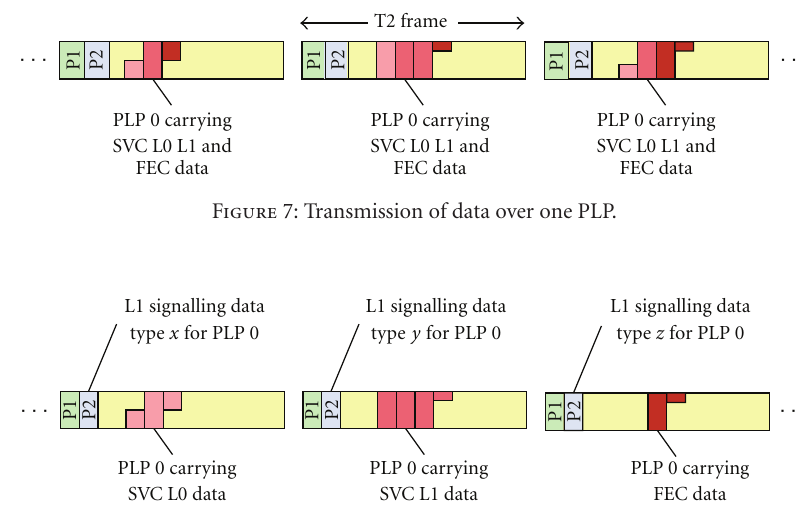
Figure 8: Transmission of scheduled data over one PLP with additional L1 signalling.